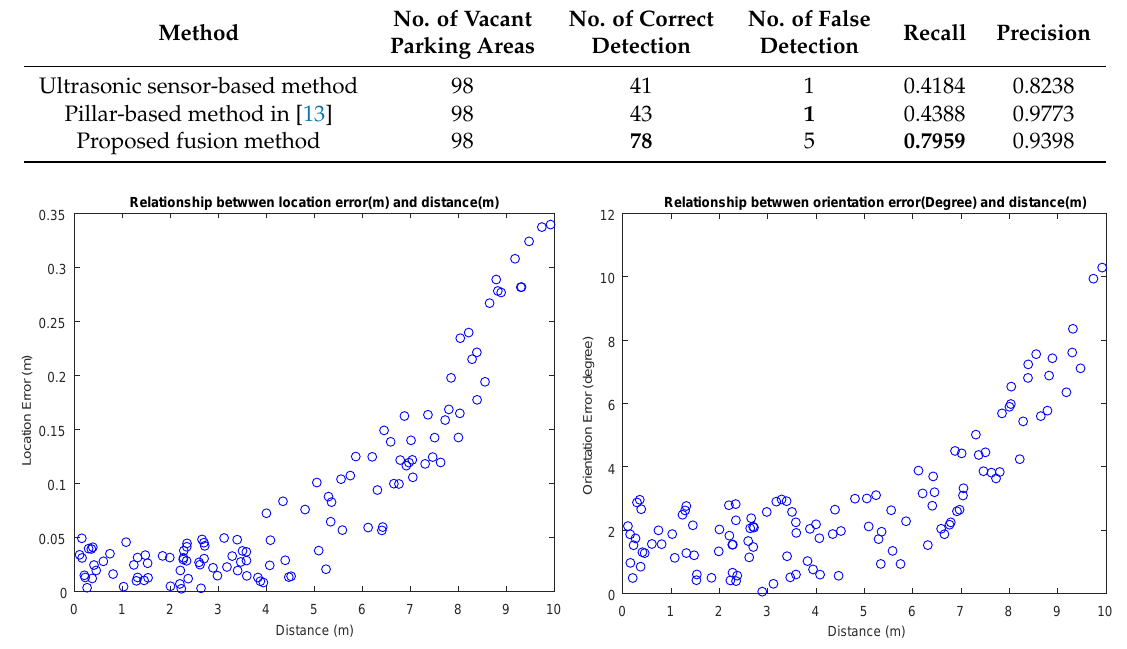
Figure 14. Left : location error of 120 samples. Right : orientation error of 120